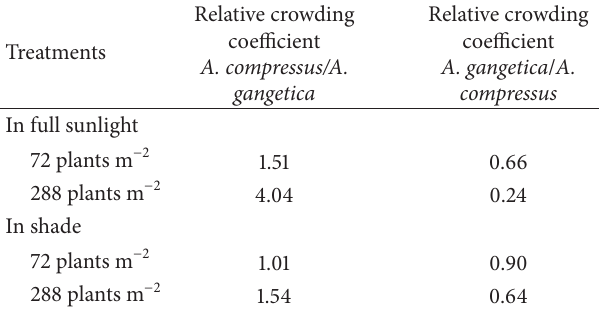
Table 3: Relative crowding coefficient in interaction between A. compressus and A.